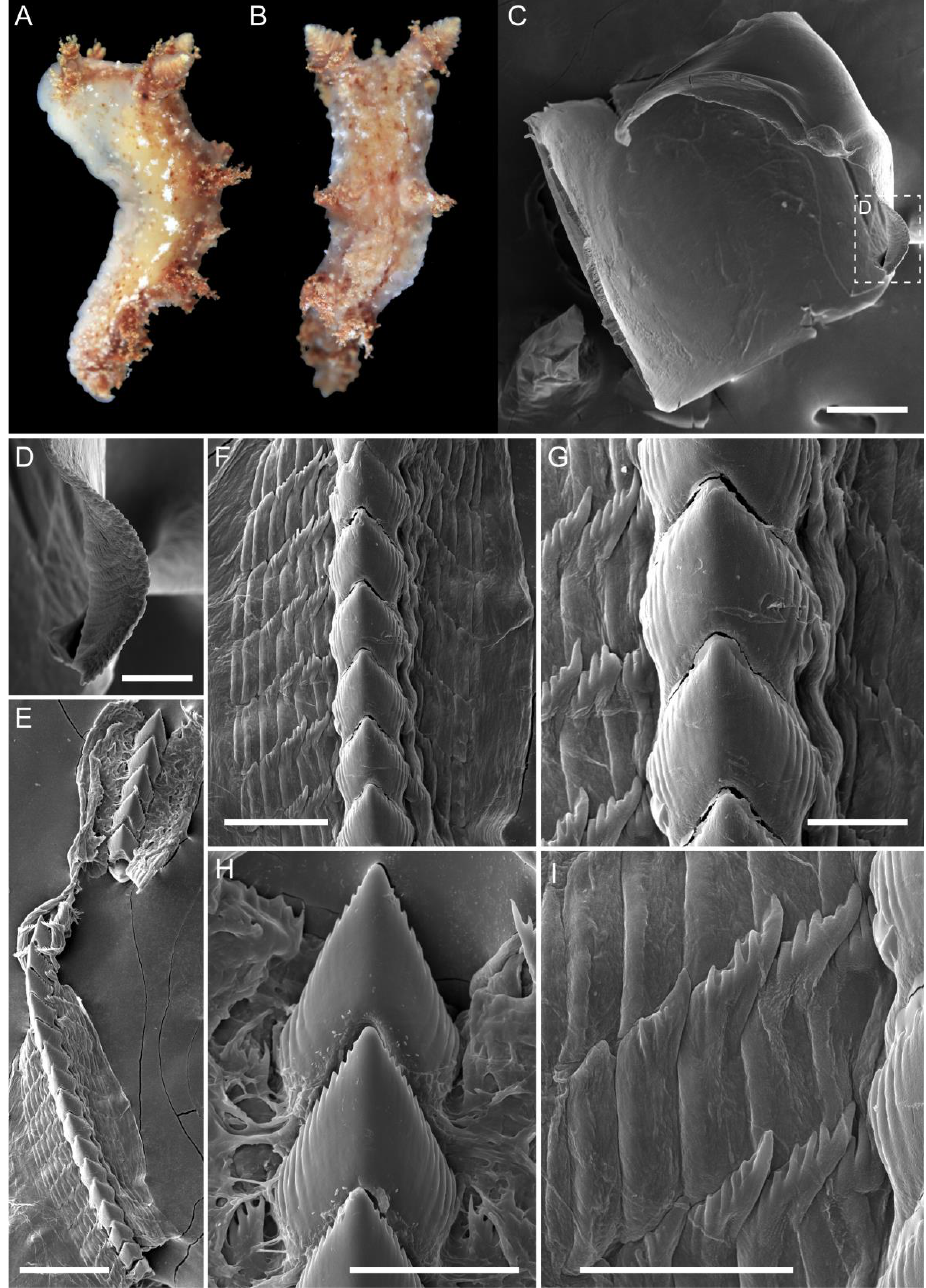
Figure 9. Dendronotus sp. 2, features of external and internal morphology (SEM), MIMB44625. ( A , B ) — living specimen, lateral view from the left ( A ) and dorsal view ( B ). ( C ) — left jaw plate. ( D ) — masticatory process of the jaw. ( E ) — radula. ( F ) — anterior radular portion. ( G ) — rachidian teeth, anterior radular portion. ( H ) — rachidian teeth, posterior radular portion. ( I ) — lateral teeth. Scale bars: ( C , E ) = 100 µm; ( D , F ) = 20 µm; ( E , H ) = 20 µm; ( I ) = 10 µm.